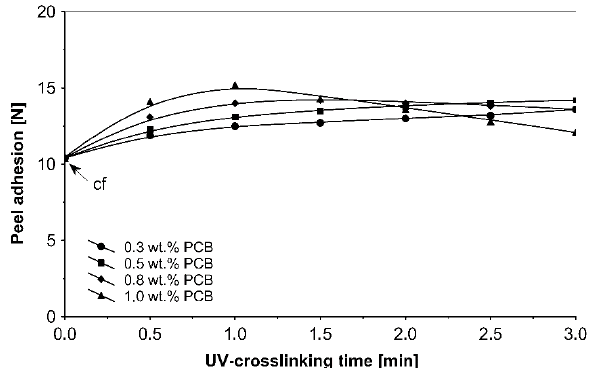
Figure 5. Tack of cross-linked acrylic PSAs containing various amounts of additionable photoinitiator versus UV-crosslinking time.